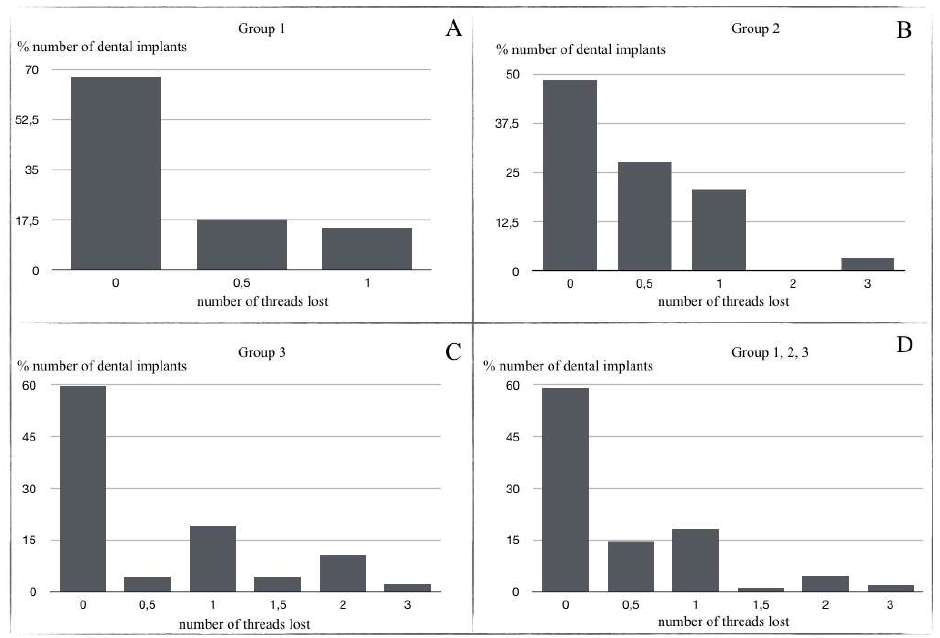
Figure 6. ( A ) Thread loss in Group 1 (after 1–3 years prosthetic loading); ( B ) Thread loss in Group 2 (after 3–5 years prosthetic loading); ( C ) Thread loss in Group 3 (up to 10 years prosthetic load- ing); ( D ) Mean thread loss in total sample. ( D ) Mean thread loss in total